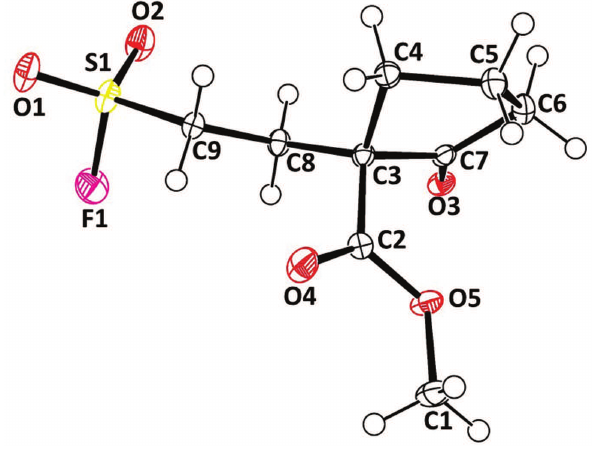
Table 1: Data collection and